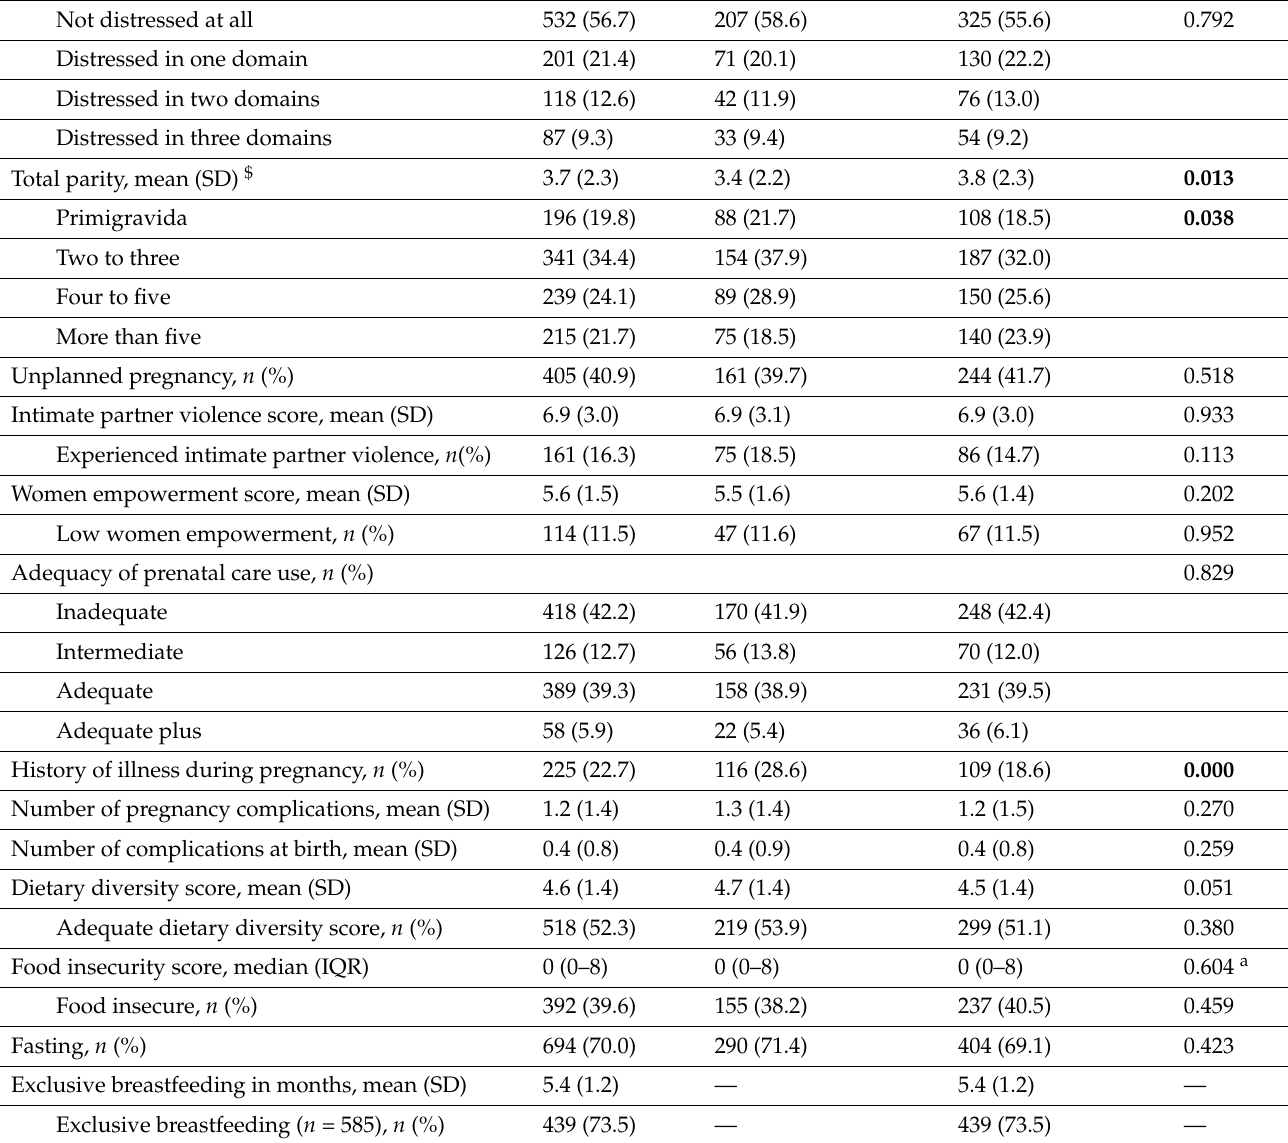
Table S1). The postpartum weight change in kg in relation to pre-pregnancy body